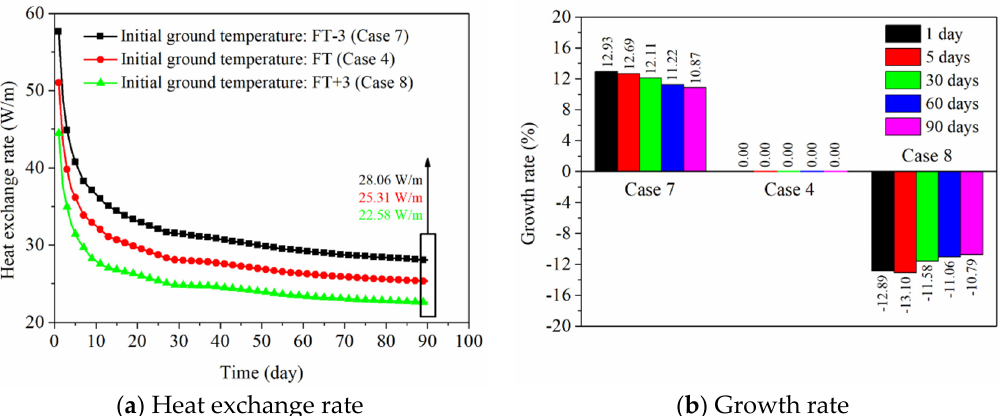
Figure 15. Effect of initial ground temperature on the thermal performance of energy pile.